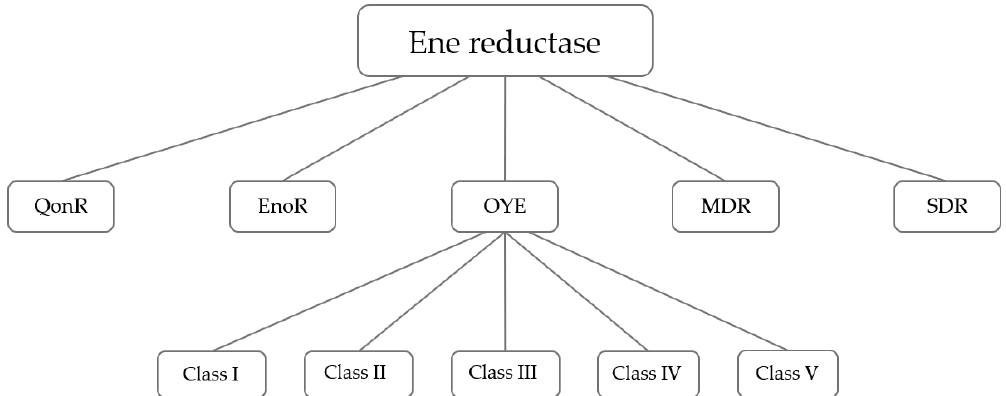
Figure 1. Overview of the classification within the ene reductase family [15]. QnoR (NADPH-dependent quinone reductase like ene-reductases), EnoR (enoate reductase), OYE (old yellow enzyme), MDR (medium-chain dehydrogenase / reductase), and SDR (short-chain dehydrogenase / reductase); Class I (classical OYE); Class II (thermophilic-like OYE) and Class V (fungal OYE).